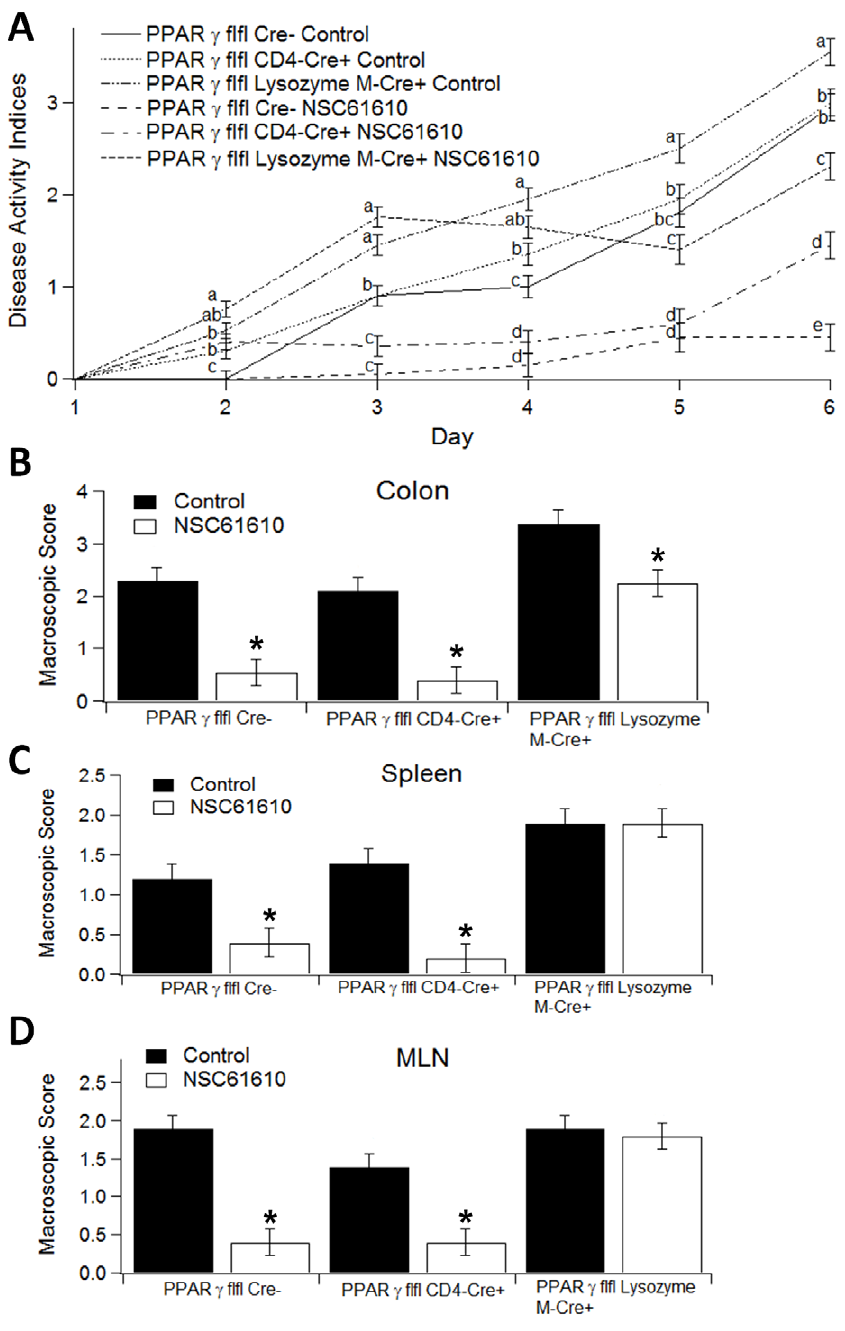
Figure 8. Effect of tissue-specific PPAR c deletion and oral NSC61610 treatment in experimental inflammatory bowel disease. Mice were challenged with 2.5% dextran sodium sulfate in the drinking water. Panel A illustrates the effect of oral NSC61610 treatment on disease severity. Means within time points with different letterssuperscripts are significant different ( P , 0.05). Panels B–D illustrate the effect of oral NSC61610 on macroscopic lesions in the colon (B), spleen (C), and mesenteric lymph nodes (MLN) (D). Data are represented as mean 6 standard error (n=10). Bars with an asterisk indicate that a treatment is significantly different from its control ( P , 0.05 ).